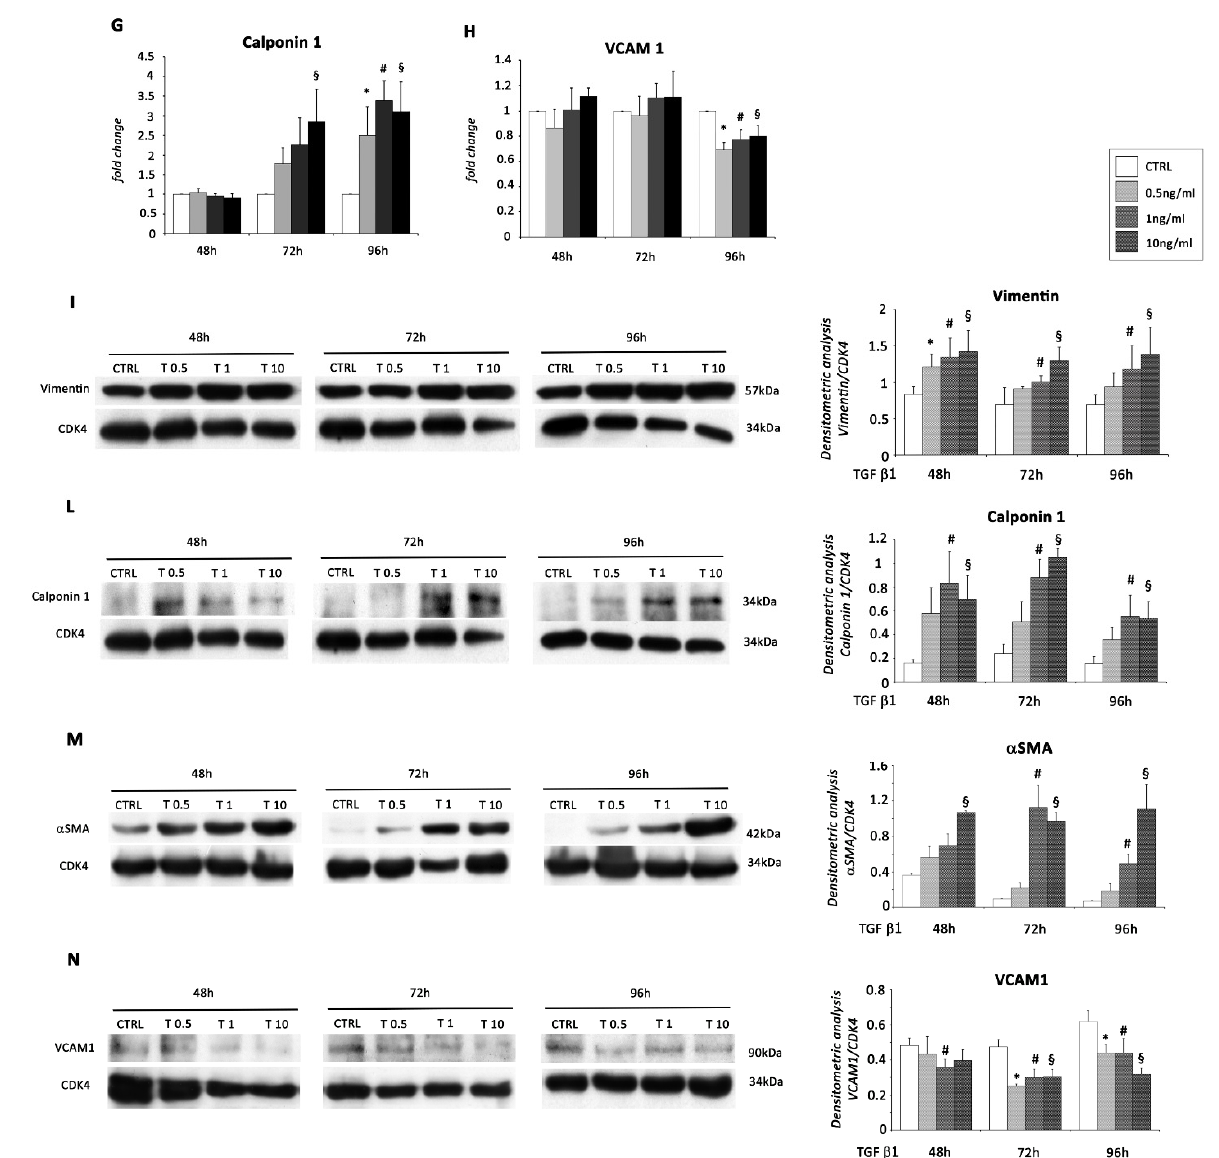
Figure 1. TGF β 1 treatment induces EMT in EMCs. EMCs were incubated with 0.5, 1, and 10 ng/mL of TGF β 1 for 48, 72, and 96 h. mRNA expression levels for ( A ) SNAI1, ( B ) SNAI2, ( C ) ACTA2, ( D ) SM22alpha, ( E ) Vimentin, ( F ) Fibronectin 1, ( G ) Calponin 1 and ( H ) VCAM1 were determined by real time PCR. The bar graphs show fold increases in expression of the studied genes in EMCs with respect to control untreated cells, set at 1. Data were normalized to GAPDH, a housekeeping gene, and represent means ± SEM of three separate experiments, each repeated in triplicate. *, p < 0.05 for 0.5 ng/mL of TGF β 1; #, p < 0.05 for 1 ng/mL of TGF β 1; §, p < 0.05 for 10 ng/mL of TGF β 1 vs. control conditions (CTRL). Western blot analysis showing the expression of ( I ) Vimentin, ( L ) Calponin 1, ( M ) α SMA, and ( N ) VCAM1, in EMCs stimulated with 0.5, 1, and 10 ng/mL of TGF β 1 for 48, 72, and 96 h compared to control conditions (CTRL). The same filter was probed with anti-CDK4 pAb to show the equal loading. Left panel: A representative Western blotting of three independent experiments is shown. Right panel: Densitometric analysis of Western blot. Data are shown as means ± SEM. *, p < 0.05 for 0.5 ng/mL of TGF β 1; #, p < 0.05 for 1 ng/mL of TGF β 1; §, p < 0.05 for 10 ng/mL of TGF β 1 vs. control conditions